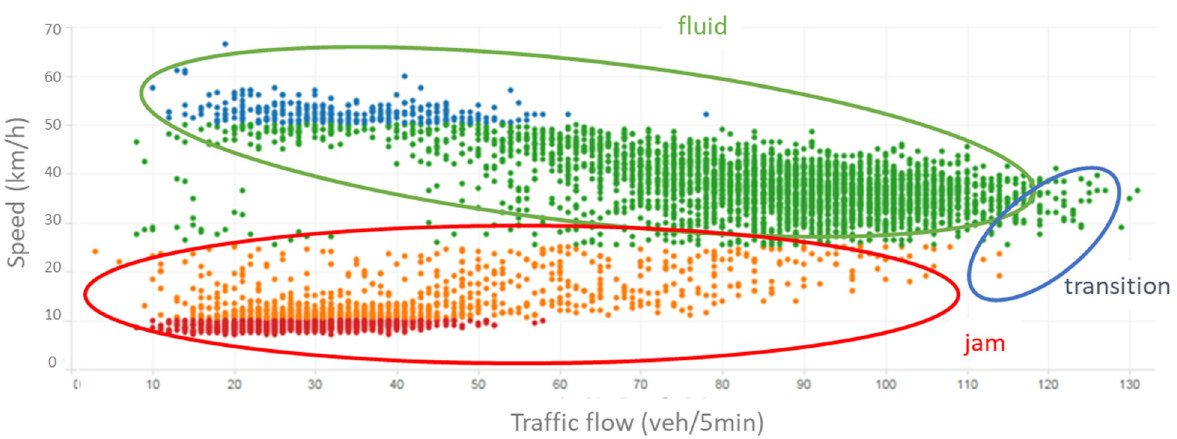
Figure 10. Data measured on Strakonicka street in Prague (October 2015) demonstrating the fluid and jammed traffic states.